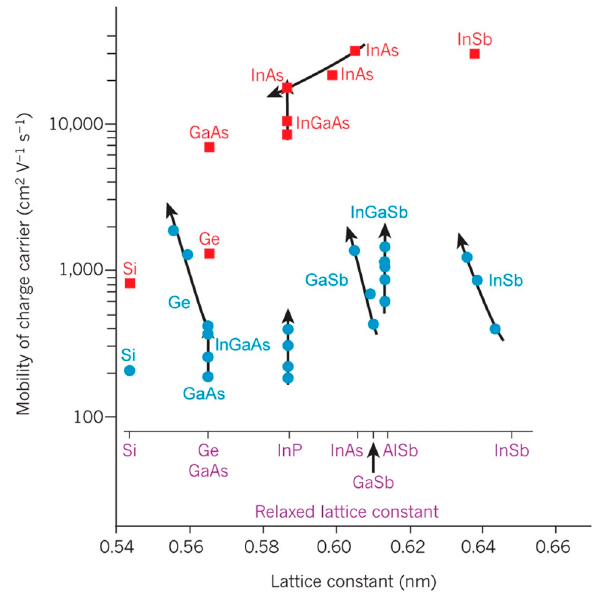
Figure 3. Carrier mobility in inversion layers and quantum wells in Si, Ge, and III-V compounds. Red symbols represent electron mobility and blue ones are marked for hole mobility. The electron mobility in the compounds shown in the plots are much higher than that in Si and Ge [50].